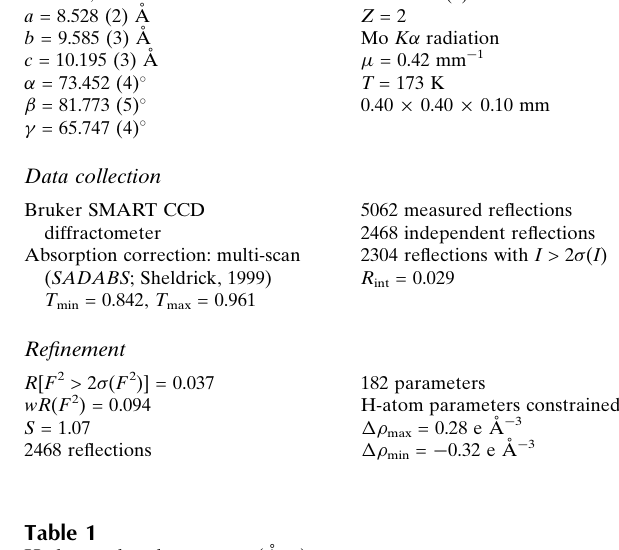
Hydrogen-bond geometry (A˚ , (cid:2)